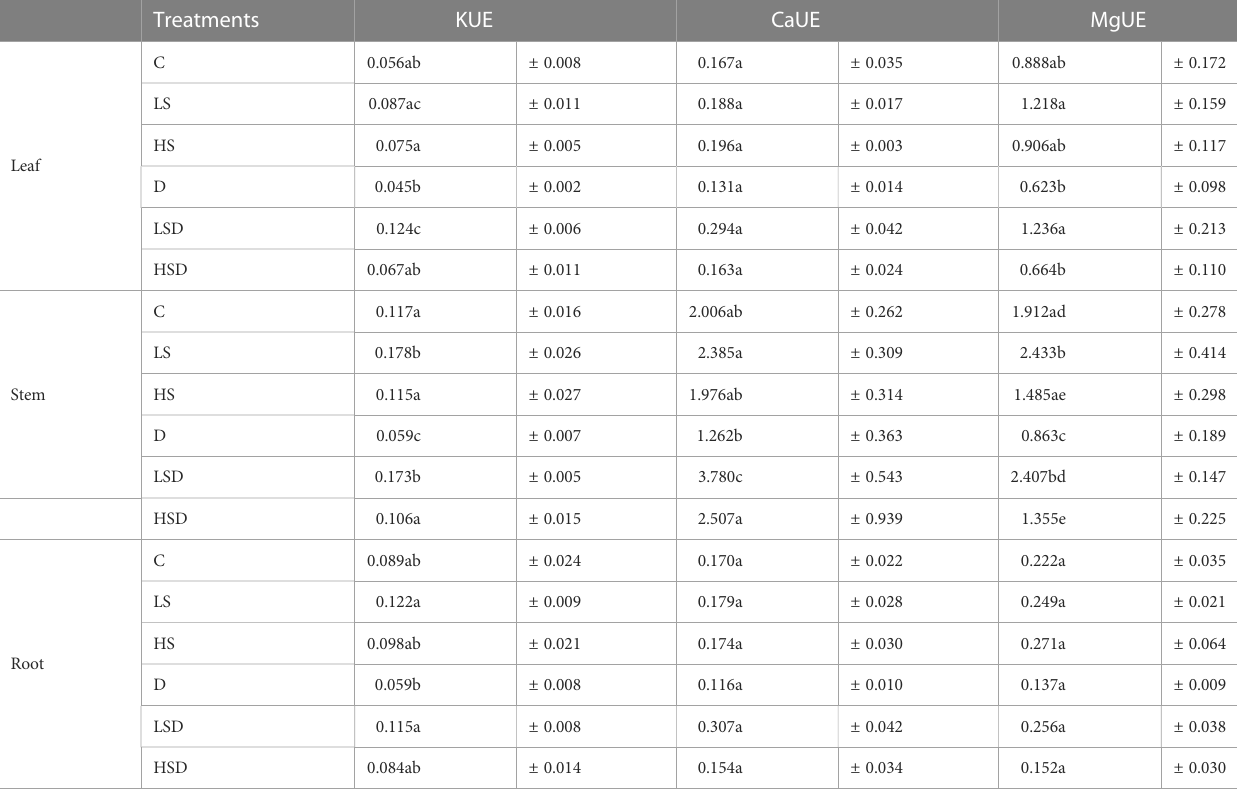
TABLE 2 The effect of salt (0, 100, 300 mM NaCl; abbreviated as C, LS, and HS respectively), drought (D) and combination of both (abbreviated as LSD and HSD) on ion use ef fi ciencies of K + , Ca 2+ and Mg 2+ (KUE, CaUE and MgUE respectively). Treatments